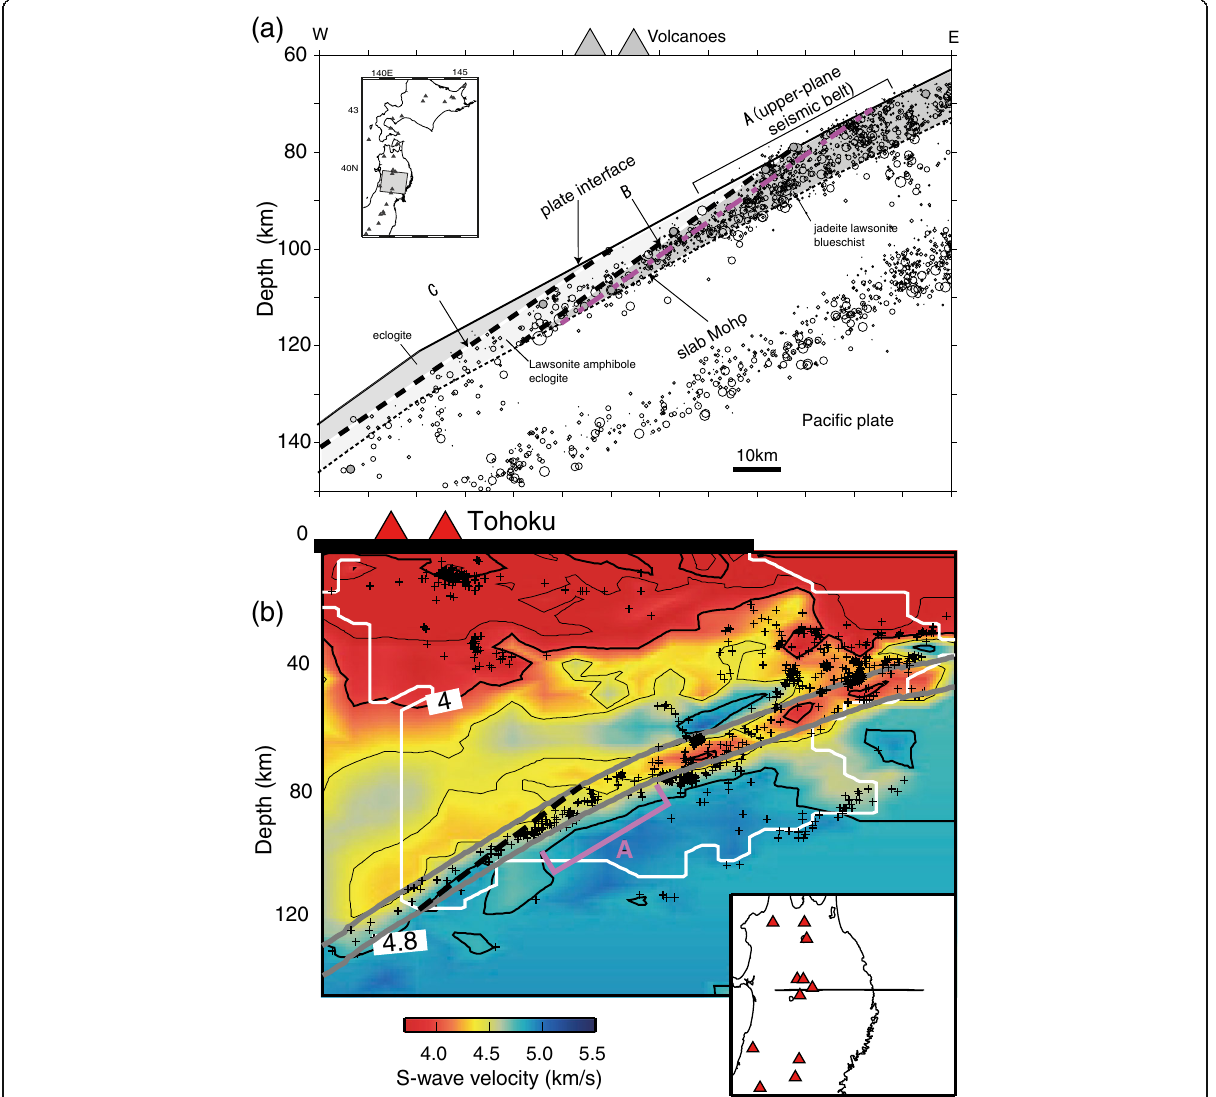
Fig. 8 Seismicity and facies boundaries in the slab crust and low S-wave velocity layer. a Across-arc vertical cross-section of intraslab earthquakes and facies boundaries in the crust of the Pacific slab under central Tohoku (modified from Kita et al.(2006)). Facies boundaries are indicated by broken black lines and a long and short dashed red line. Open circles are earthquakes. Solid and thin dashed lines are the upper plate interface and the Moho within the slab, respectively. b Across-arc vertical cross-section of S-wave velocity in central Tohoku (Tsuji et al. 2008). S-wave velocity is indicated by the color scale at the bottom. Solid line is the upper plate interface, and A denotes the upper-plane seismic